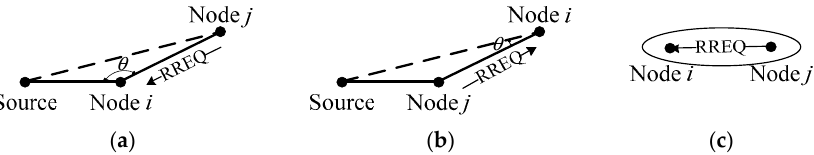
Figure 5. Schematic diagram of forward/backward judgment. ( a ) forward list; ( b ) backward list; and ( c ) nodes in short range.